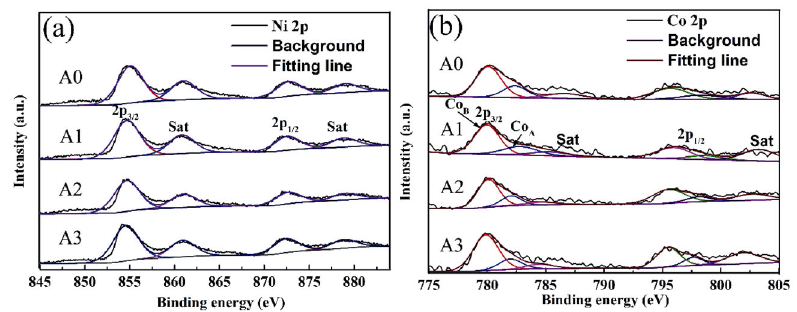
Fig. 9 XPS spectra of (a) Ni 2p and (b) Co 2p from A0, A1, A2, and A3